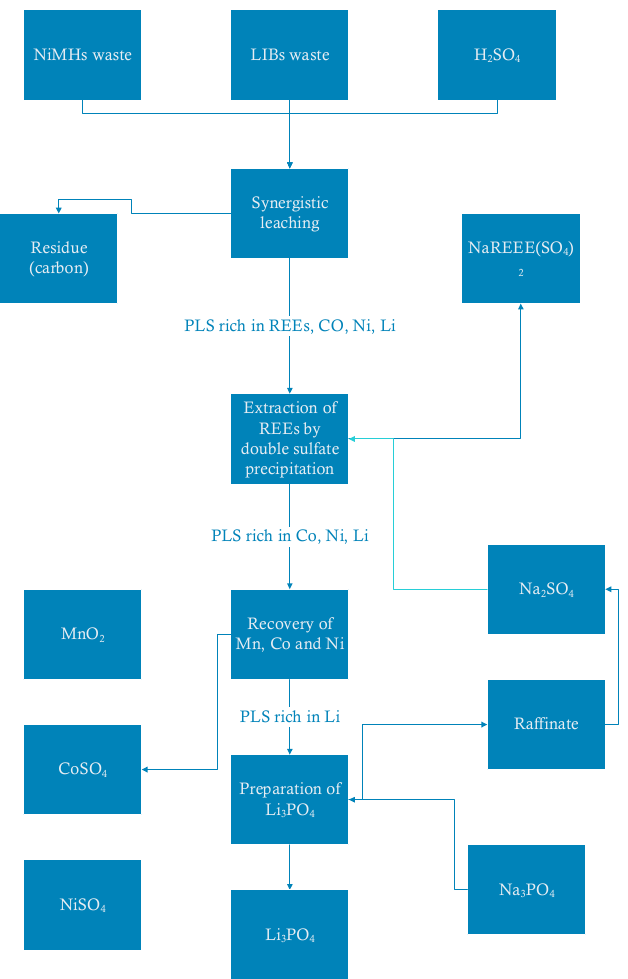
Figure 9. Recovery of REEEs, Li, Ni and Co using H₂SO₄ leaching process, redrawn from Liu, Peng, Porvali, Wang, Wilson and Lundstrom [67].